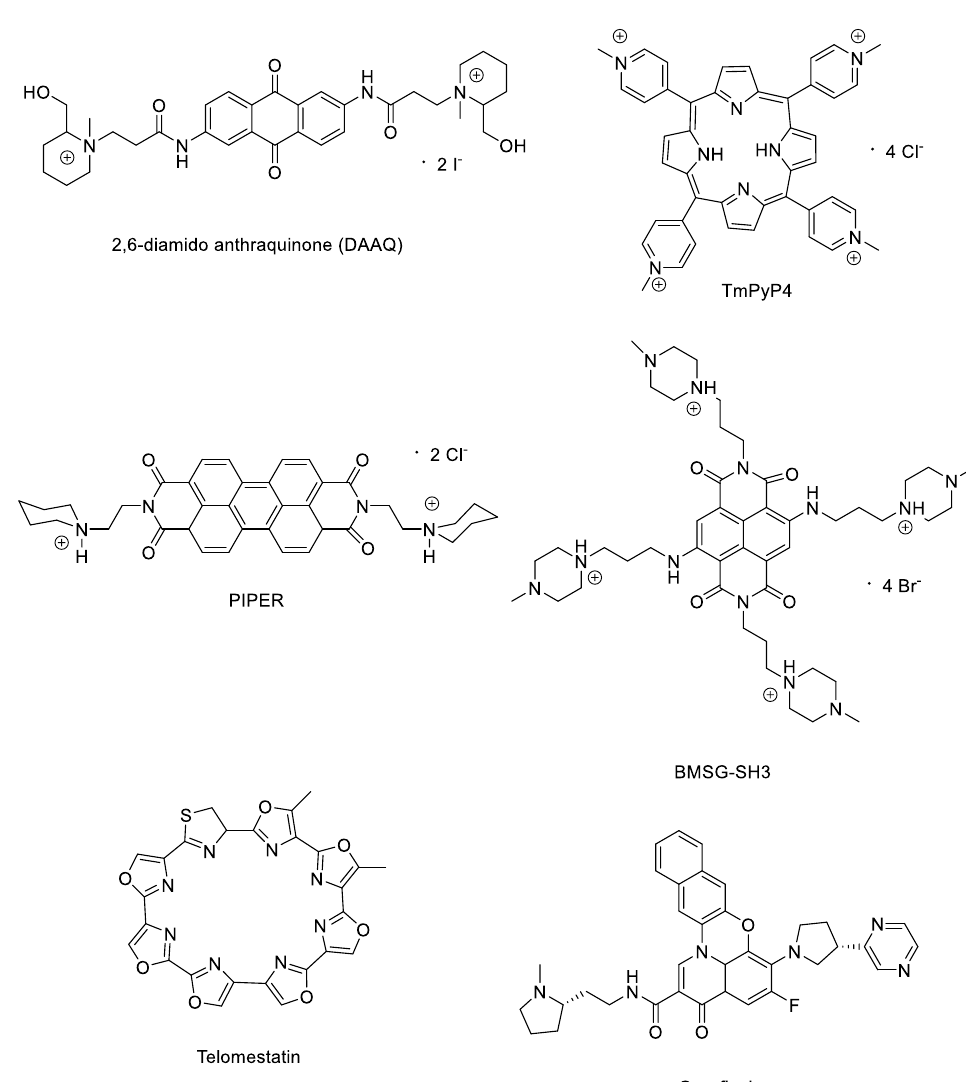
Scheme 1. Chemical structures of some interesting G − quadruplex